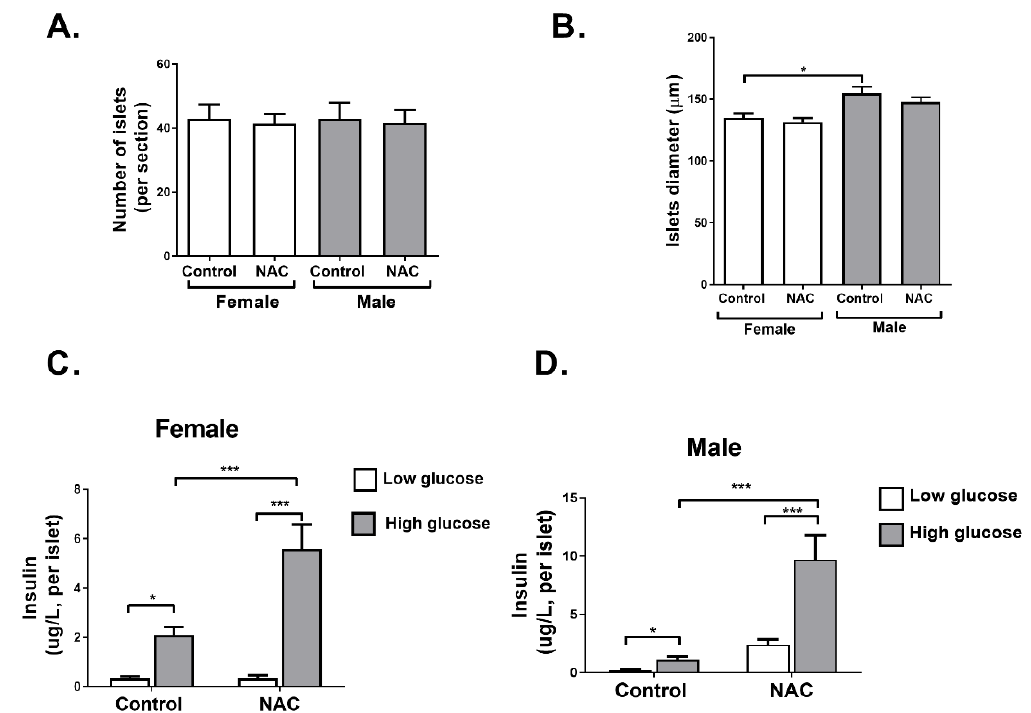
Figure 6. NAC improved pancreatic islet function in young offspring. NAC was given to females during pregnancy and lactation. Offspring were killed at age of 6 weeks, H&E staining of pancreas was performed, and number of islets per section ( A ) and islet diameter ( B ) were measured (5 mice, 3 sections for each pancreas). In additional set of 6 weeks old offspring, pancreatic islets were isolated and glucose stimulated insulin secretion (GSIS) was performed as described in Methods ( C and D ). The results are presented as mean±SE ( n = 6, 3 internal replicates for each experiment), * p < 0.05, *** p < 0.0005 in one-way Anova followed by Tukey's post-test.